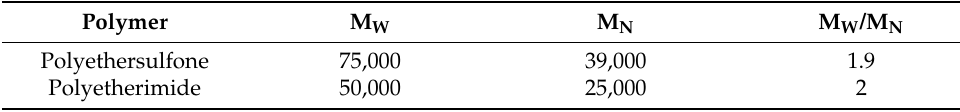
Table 2. The Molecular weight of